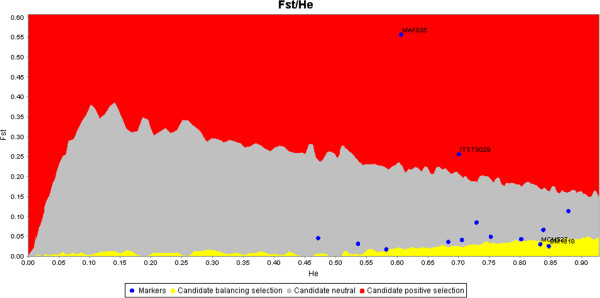
Graphical output from LOSITAN. Outliers are tagged with labels.